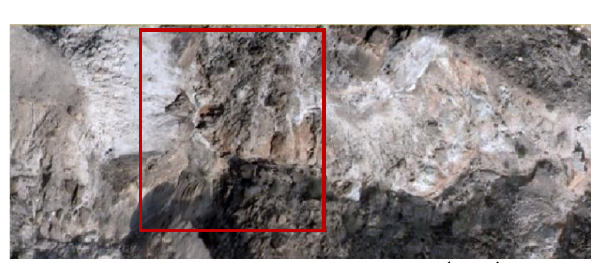
Figure4, Part of first orthophoto